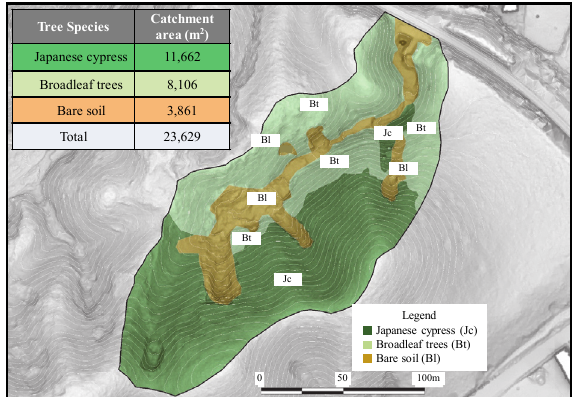
Figure 4. Land cover classification for the target